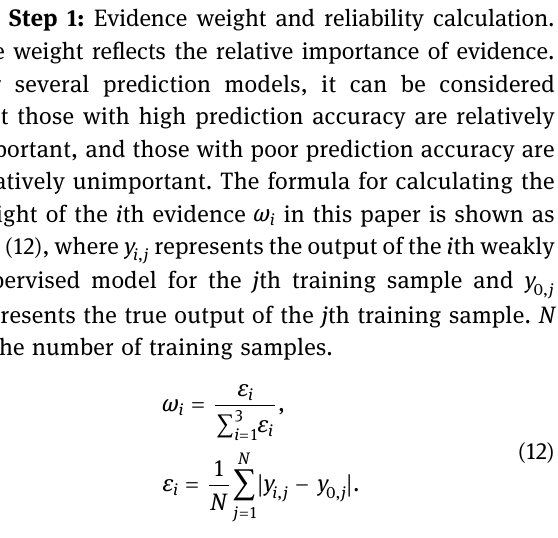
which captures long - term features and controls how the hidden state is updated by the current input. H t  is the candidate state, which controls how the information is updated. H t is the hidden layer state, and it determines which information is retained. σ ( ) ⋅ denotes the sigmoid activation function, which limits the output of the gate between 0 and 1. ⊙ represents the product of the elements between matrix. W and b are the weight matrix and bias vector, respectively. g ( ) ⋅ denotes a nonlinear activation function of the output layer.